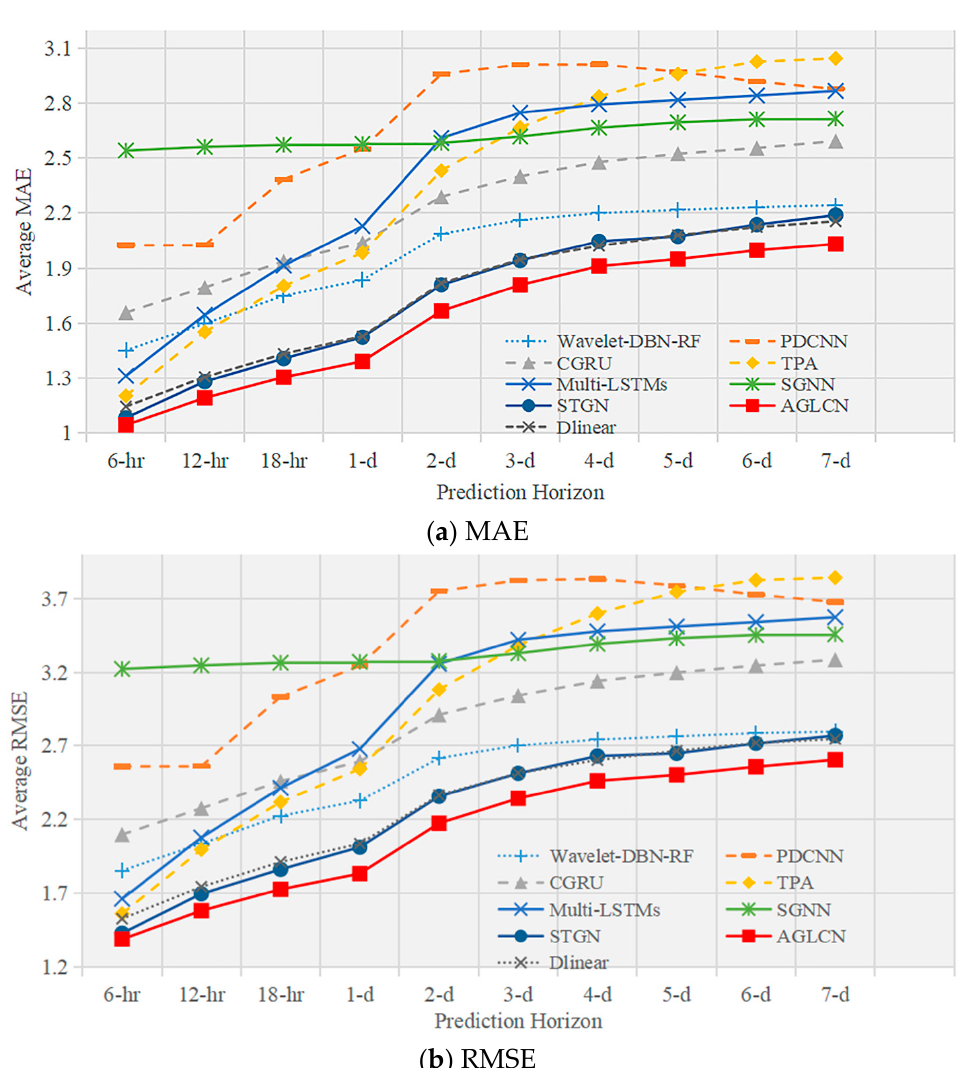
Figure 5. The performance in the multi-scale wind speed prediction on 120